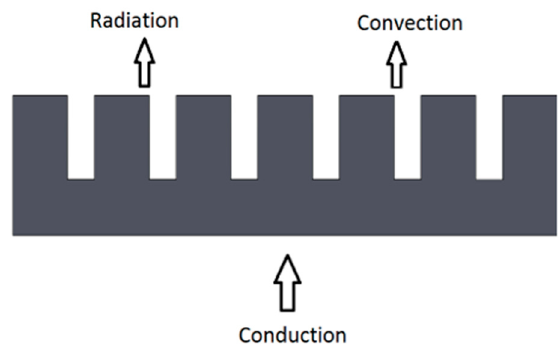
Figure 4. Heat transfer modes between the heat sink and the surrounding.